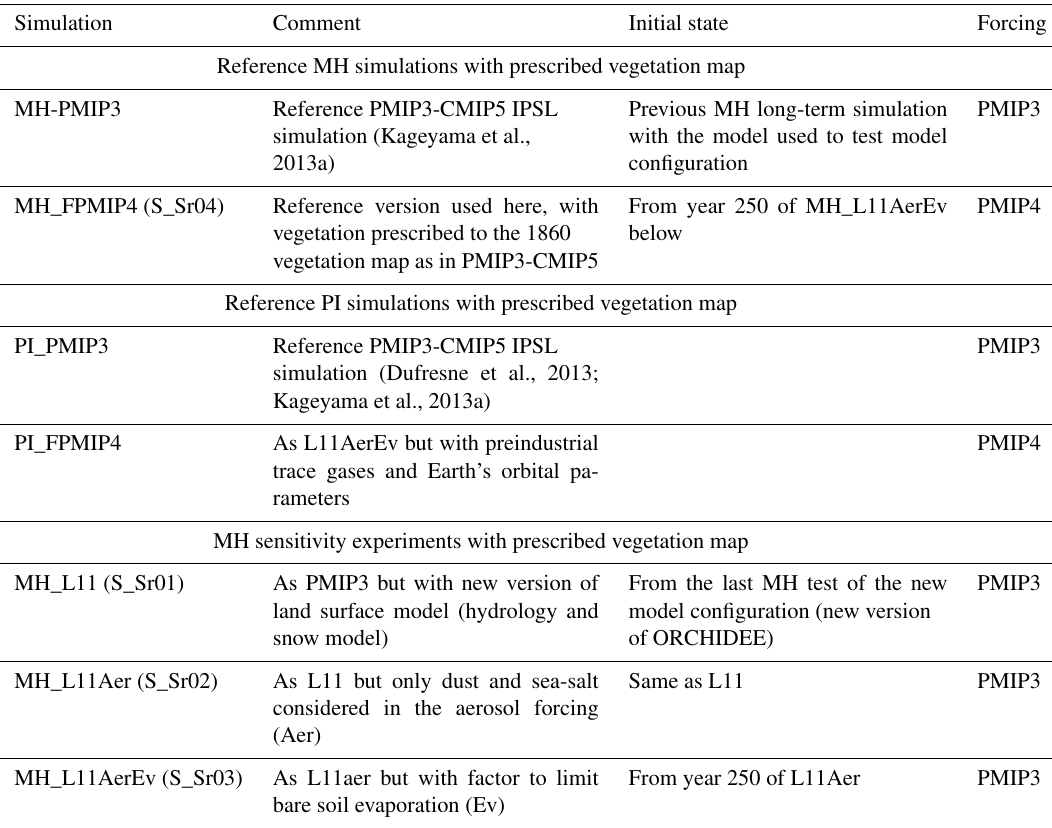
Table 1. Tests done to set up the model IPSL version in which we included the dynamical vegetation. For all these simulations the vegetation map is prescribed to the 1860CE map used in PI-PMIP3. The different columns highlight the name of the test and the initial state to better isolate the different factors contributing to the adjustment curves in Fig. 1. We include in parentheses the tag of the simulation that corresponds to our internal nomenclature for